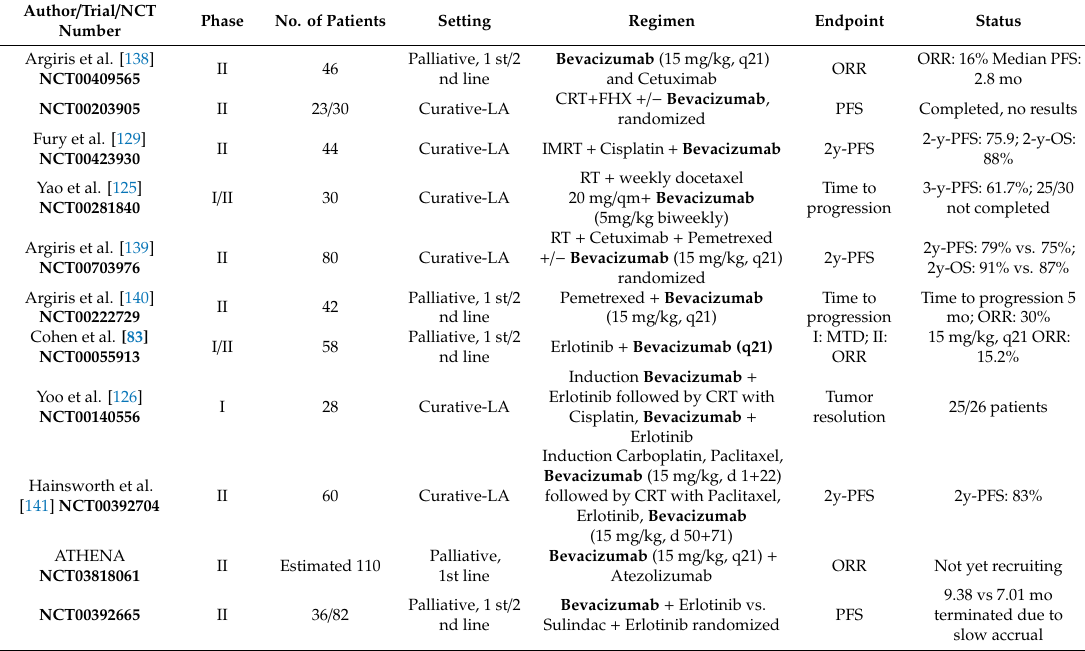
Table 4. Selected trials implementing VEGF-inhibition by